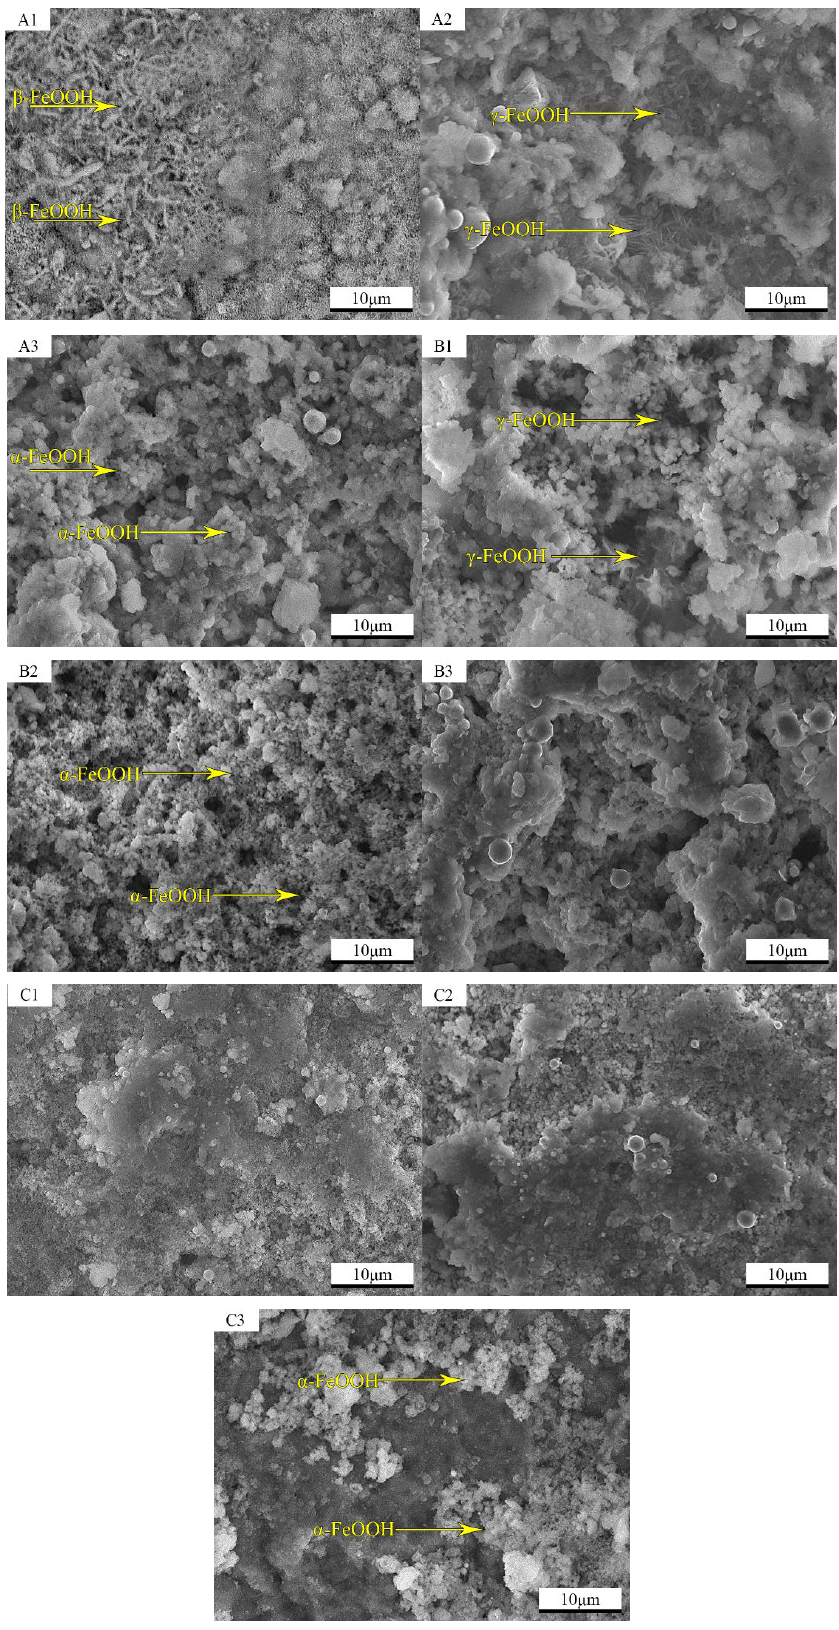
Figure 4. SEM micrographs of the rust layer for the three experimental steel groups. ( A1 – A3 ) refers to WS0.12Si steel at the 6th cycle; ( B1 – B3 ) refers to WS0.34Si steel at the 30th cycle; ( C1 – C3 ) refers to WS0.48Si steel at the 120th cycle.